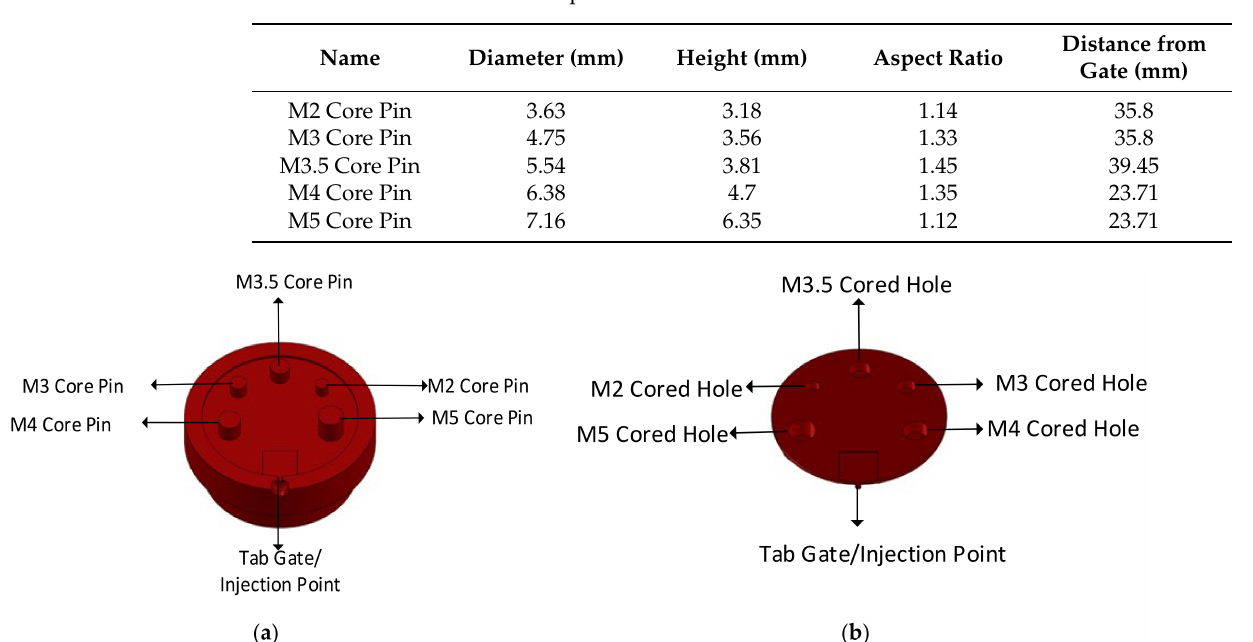
Table 1. Dimensions of the core pin.